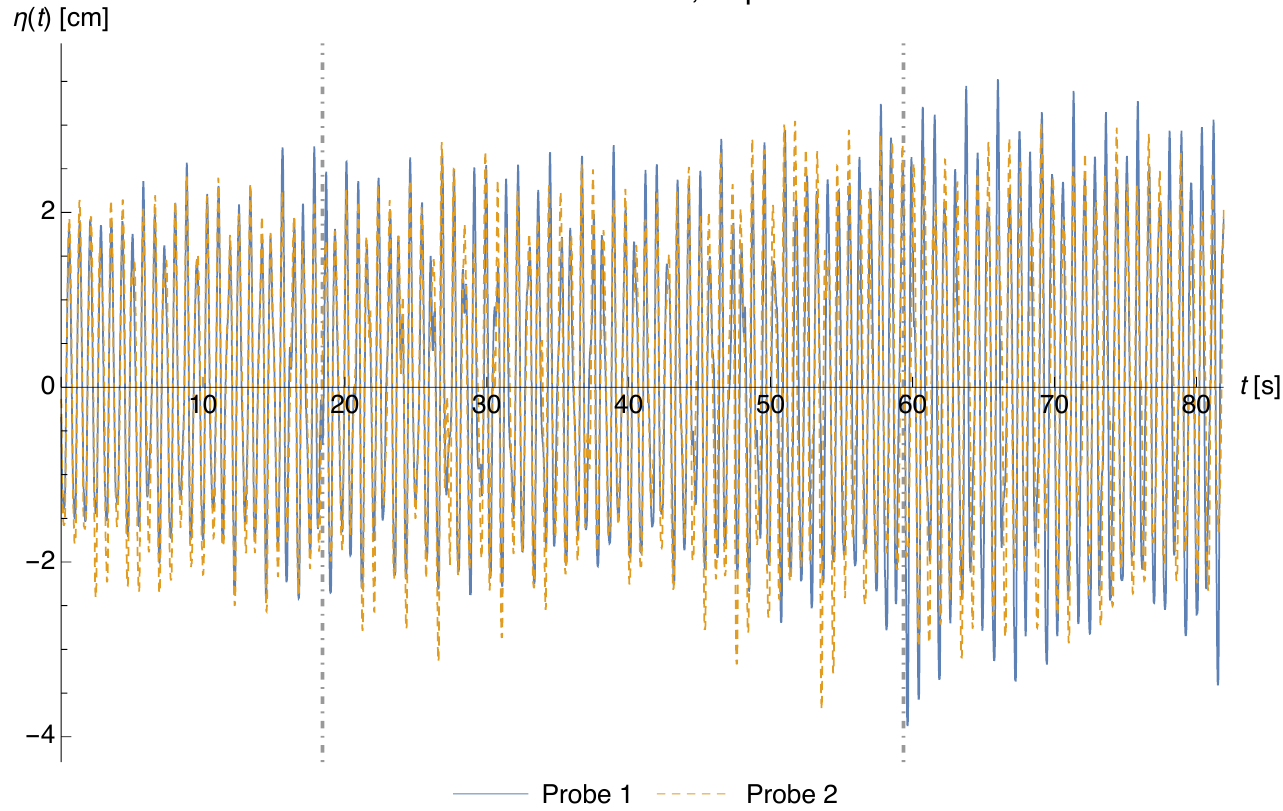
Figure 13. Plots of the probe measurements for experiment number 7. The vertical lines correspond to the first time t 0 the wavepackets with wavevectors ± K 3 arrive at the probes (leftmost line), and the time t 1 the wavepackets with wavevectors ± K 2 arrive at the probes after reflection from the walls of the tank (rightmost